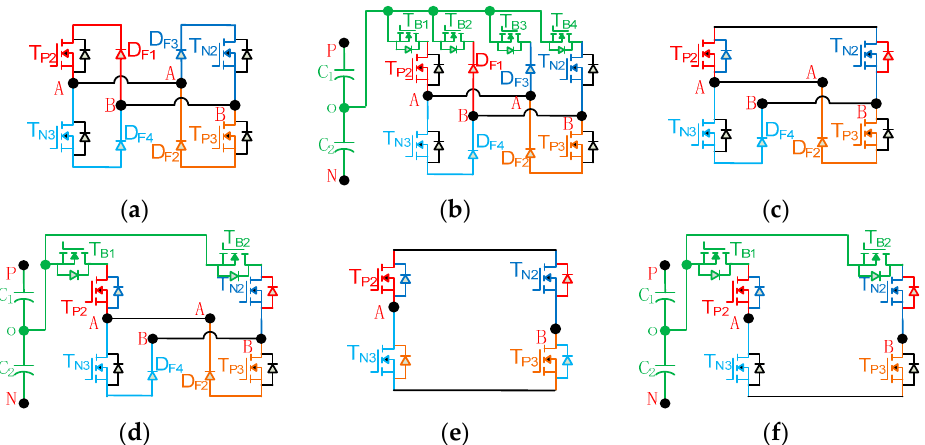
Figure 25. Direct Connection NPC cell circuits under DFUSPWM. ( a ) case #1; ( b ) NPC cell under case #1; ( c ) case #2; ( d ) NPC cell under case #2; ( e ) case #3; ( f ) NPC cell under case #3.